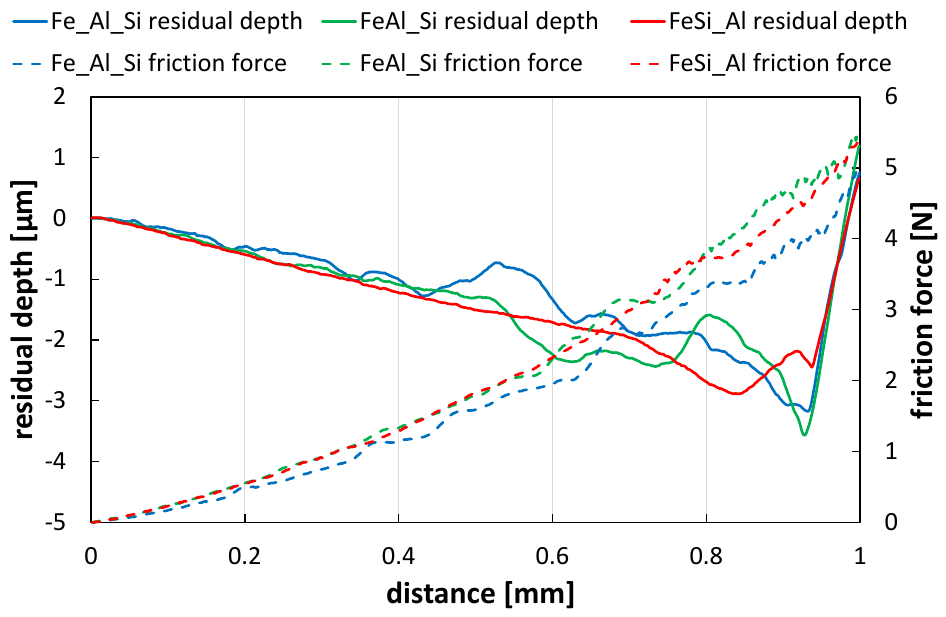
Figure 6. Comparison of residual depth and friction force.